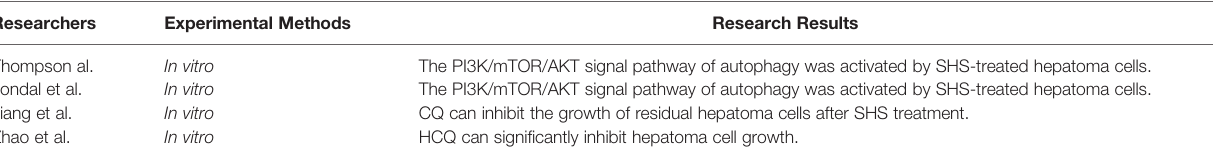
TABLE 3 | Activating autophagy in recurrence after ablation of HCC.